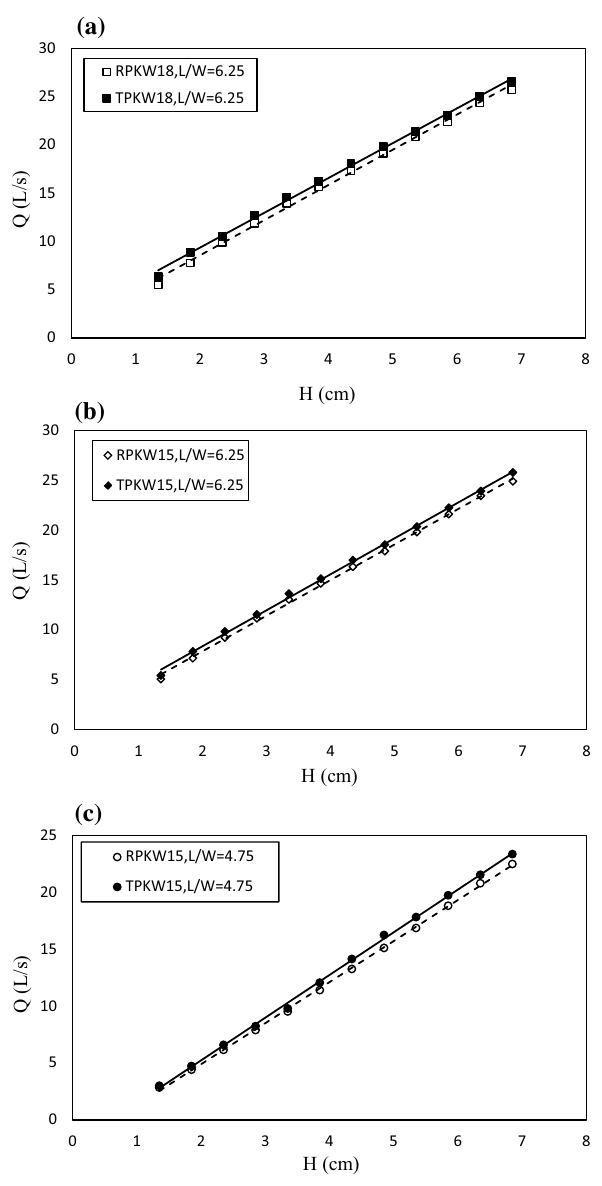
Fig. 5 Variation of discharge ( Q ) with head ( H ) showing the impact of geometrical shape